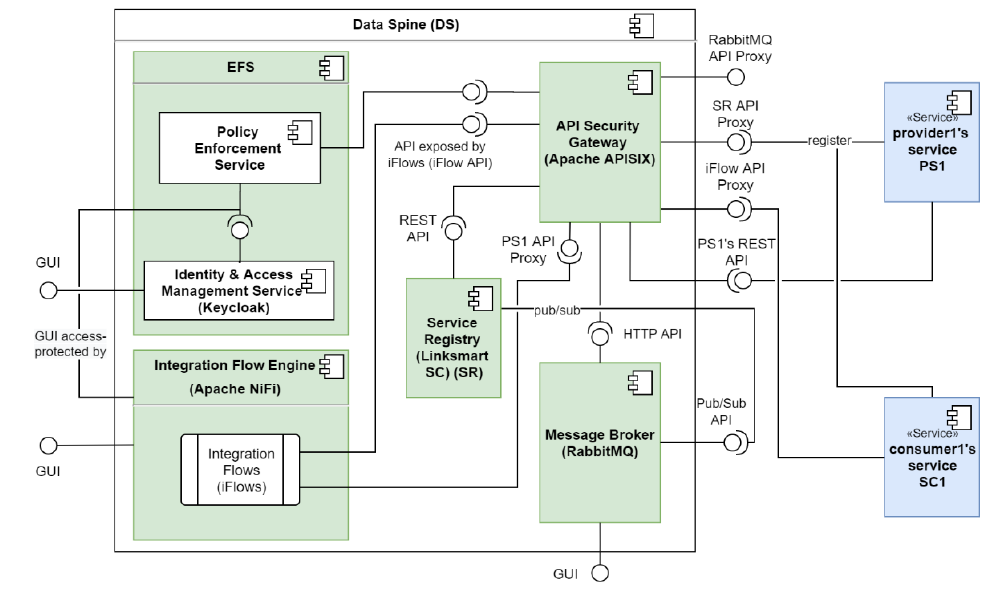
Figure 9. Synchronous services’ integration through the Data Spine.